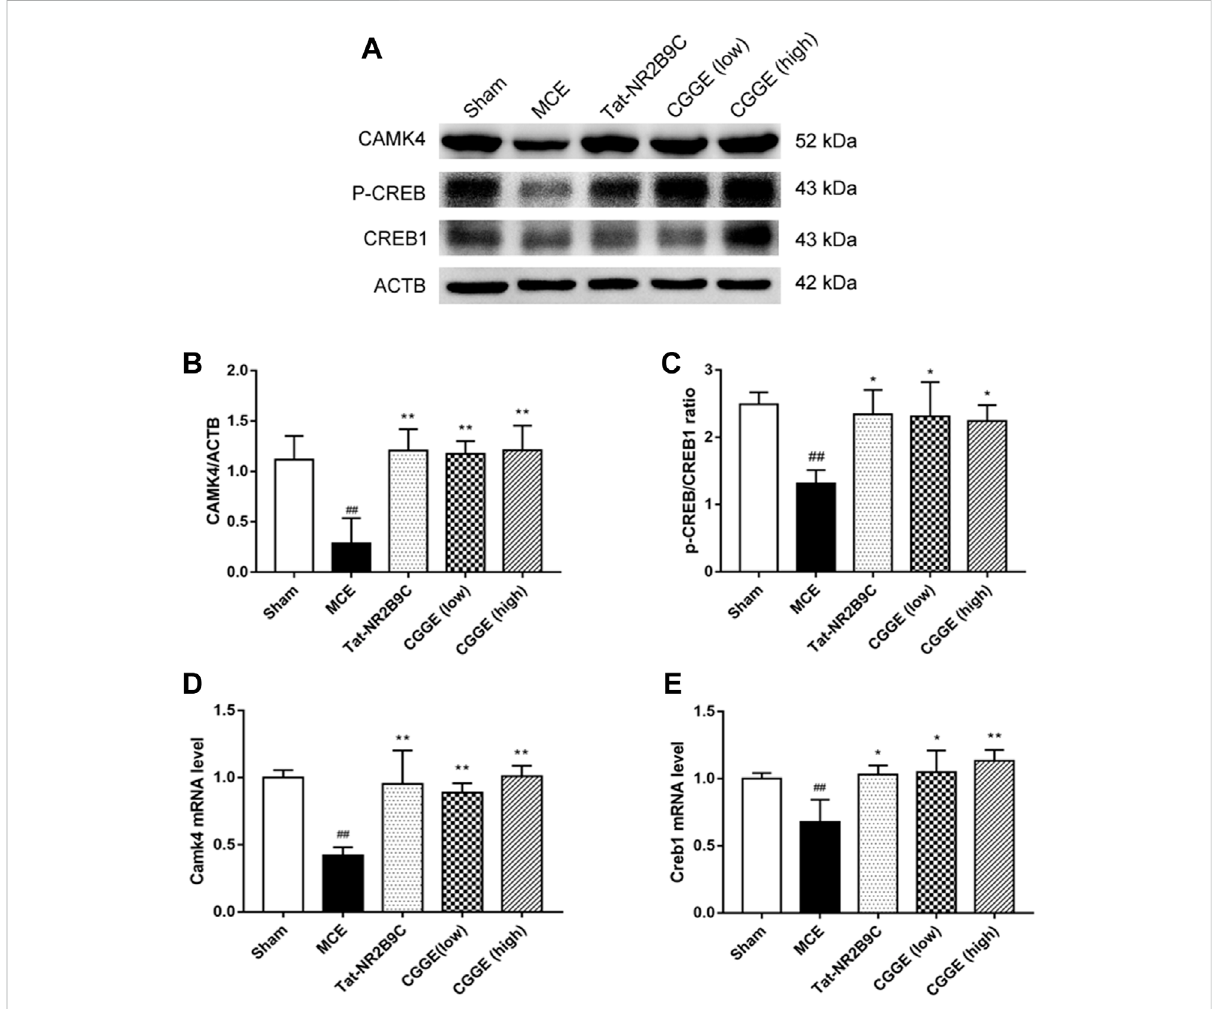
FIGURE 7 CGGE activated CaMK Ⅳ /CREB in the ipsilateral cortex. (A) Protein expression levels of CAMK4, p-CREB, CREB1. (B,C) The analysis of protein expression of CAMK4, p-CREB/CREB1. (D,E) The mRNA expression of Camk4 and Creb1 . ( ## p < 0.01, vs. sham group; ** p < 0.01, * p < 0.05, vs. MCE group) ( n =